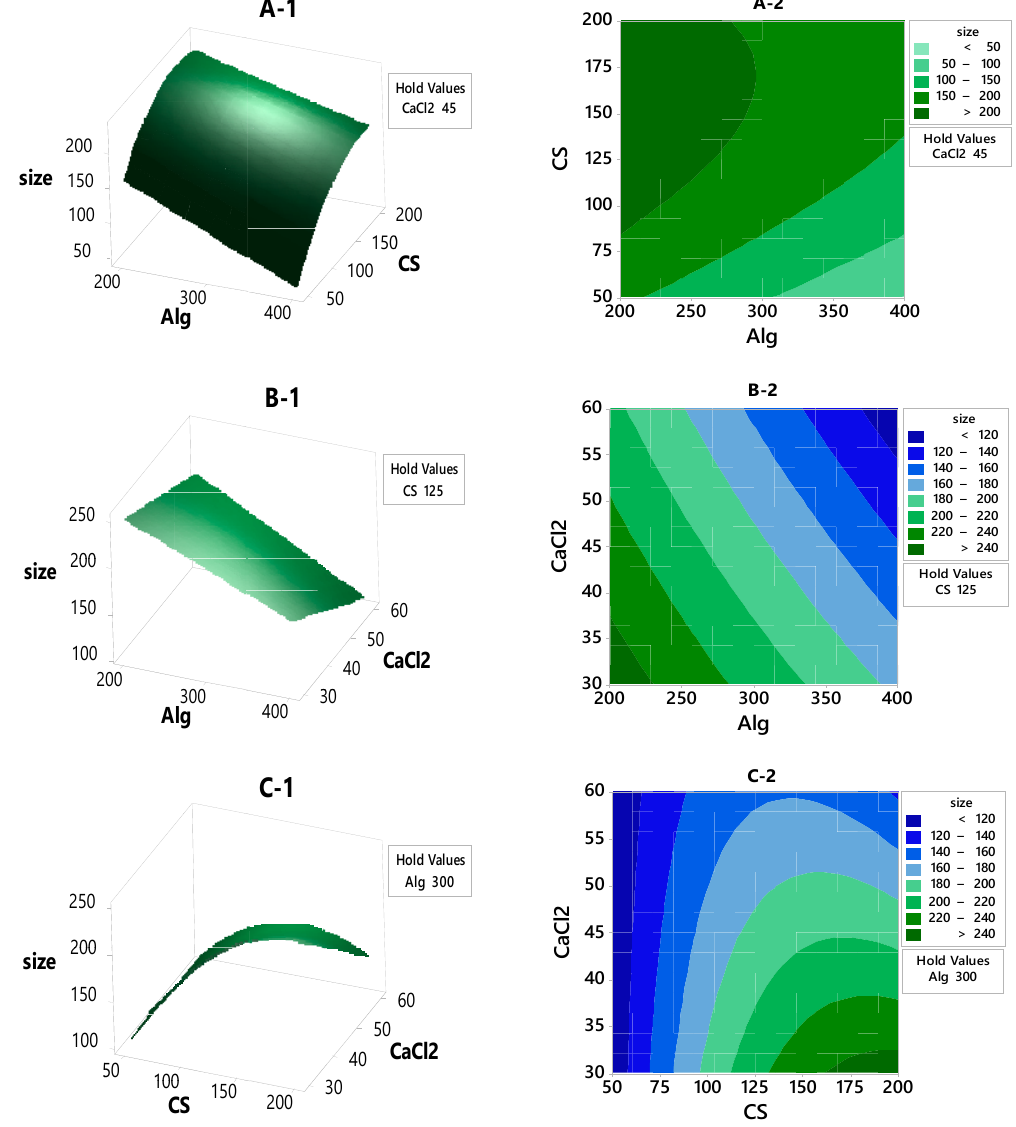
Figure 3. The contour plot and response surface of the particle size with variances of CaCl 2 , Alg and 255 CS concentrations. 256